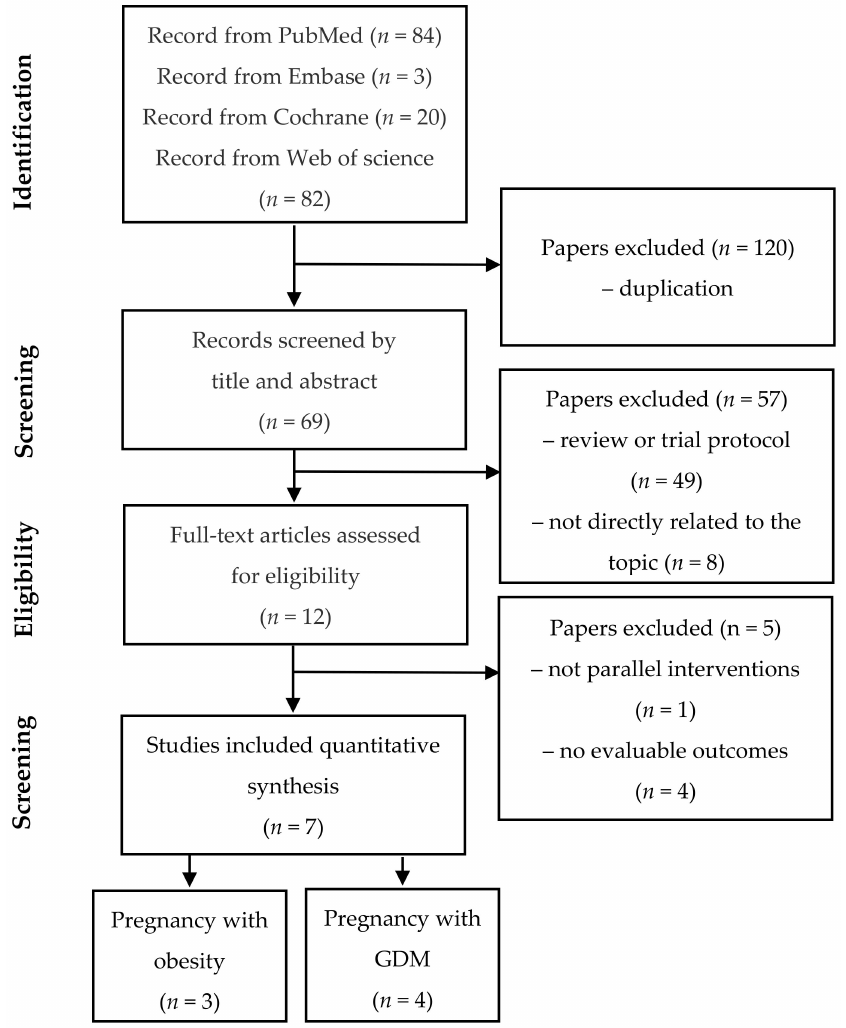
Figure 1. Flowchart of the study selection